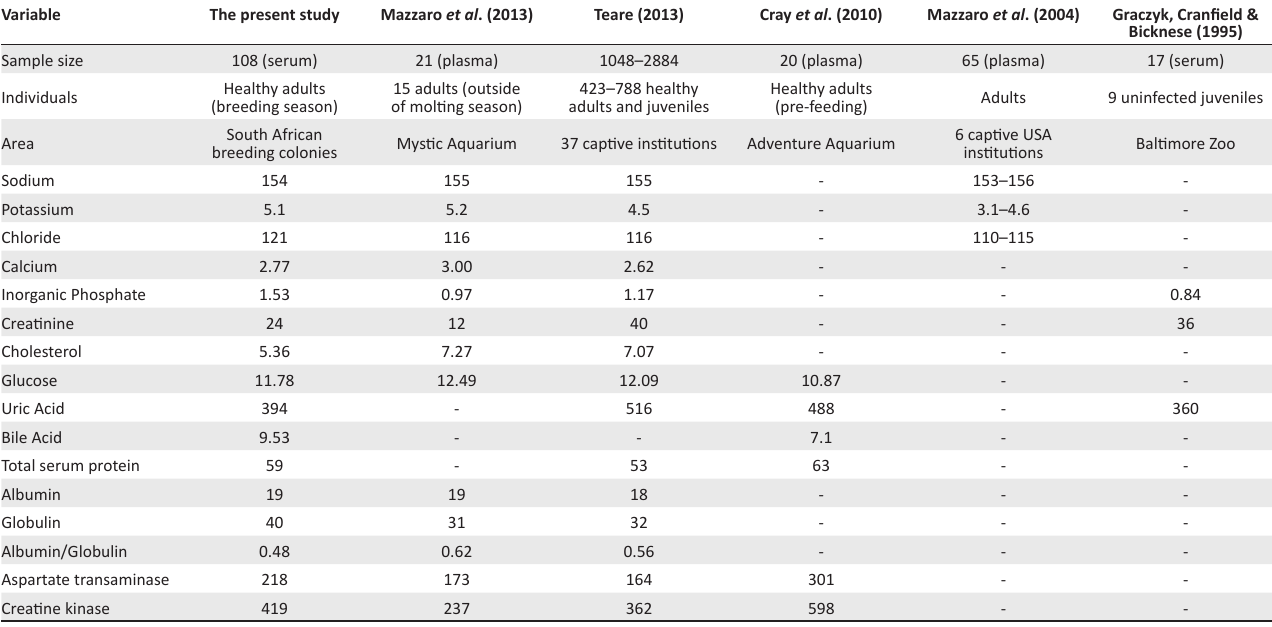
TABLE 5: Mean biochemistry values for the present study and previously published African penguin studies.